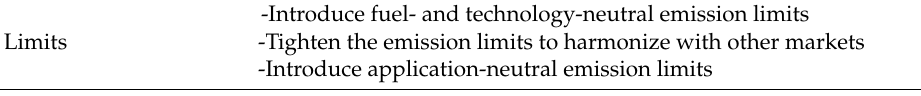
Table 7. Summary of recommendations regarding PM carbonaceous species and UFP for post-Euro 6 standards from ICCT